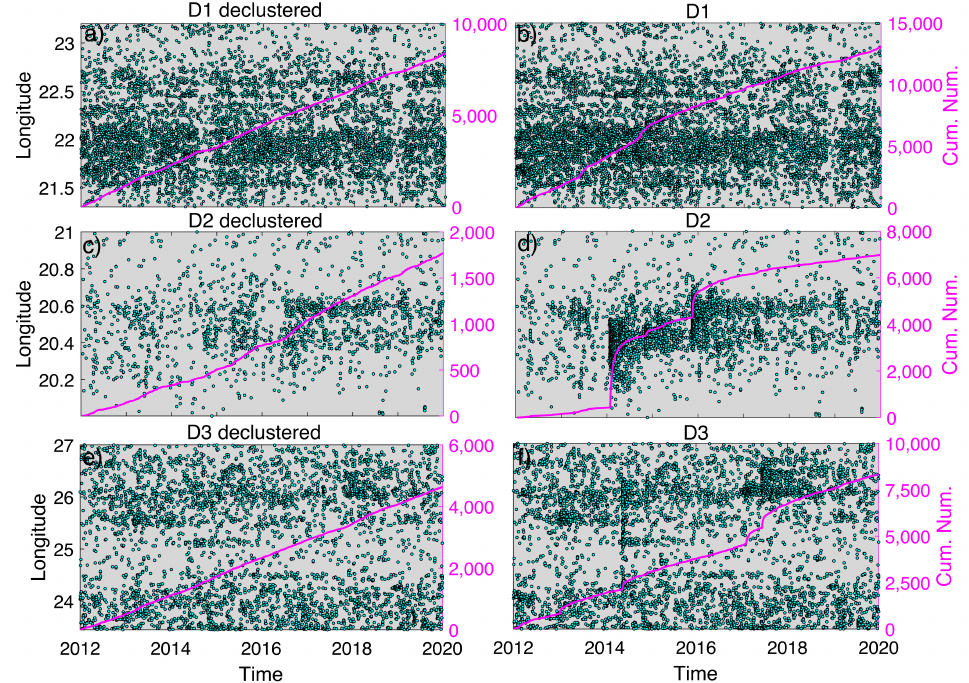
Figure A5. Space-time evolution of the background and initial seismicity for dataset ( a , b ) D1, ( c , d ) D2 and ( e , f ) D3. Purple lines denote the cumulative number of